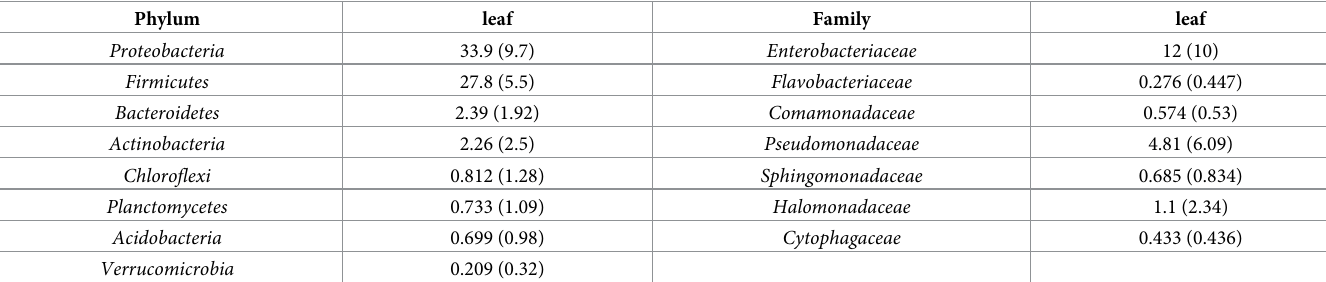
Table 2. Most abundant taxa at the phylum and family